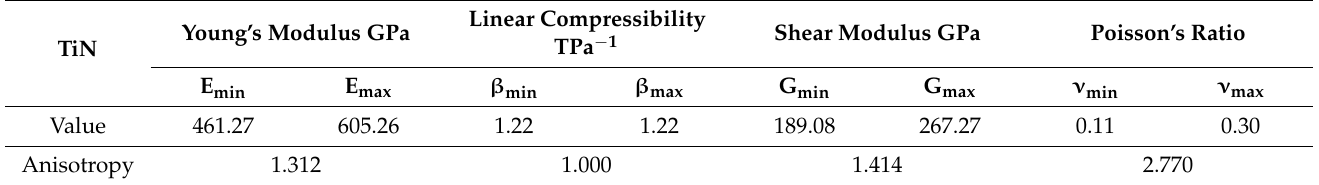
Table 4. Young ’ s modulus, linear compressibility, shear modulus, and Poisson ’ s ratio of TiN. Table 4. Young’s modulus, linear compressibility, shear modulus, and Poisson’s ratio of